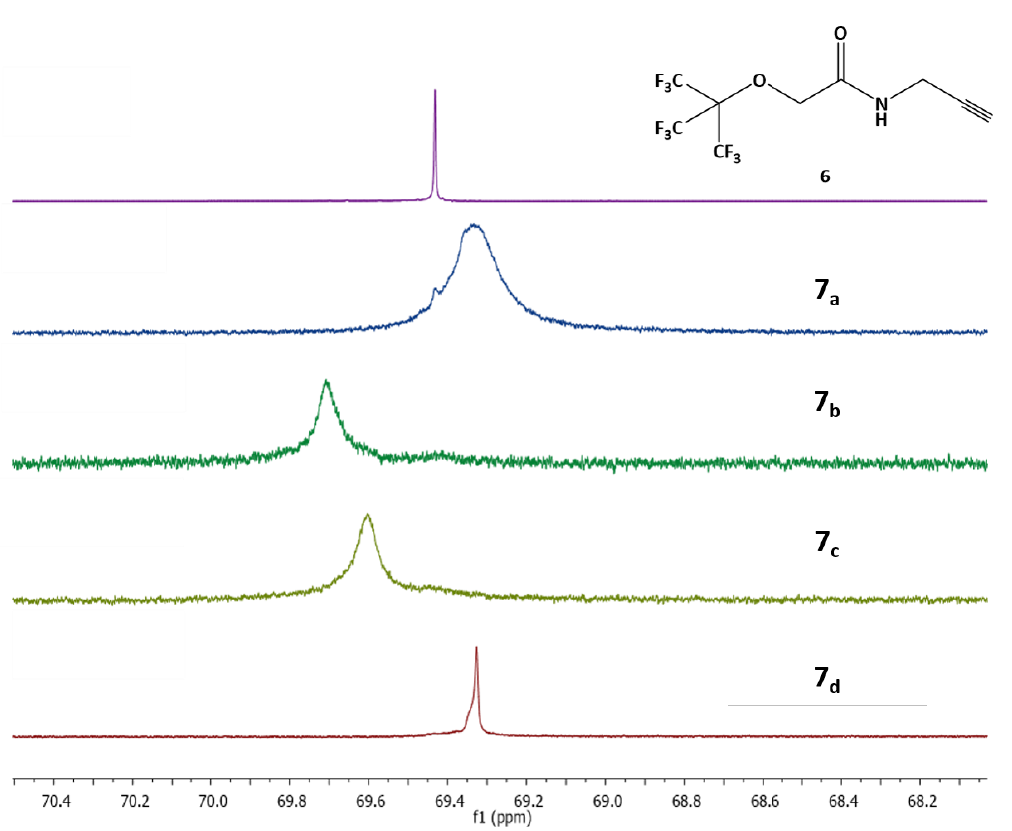
Figure 6. 19 F NMR spectra of compound 6, in purple (5 mM) and 7 a – d in blue, dark green, khaki and red (3.7 mM, 13.7 mM, 17.2 mM and 12.8 mM respectively).